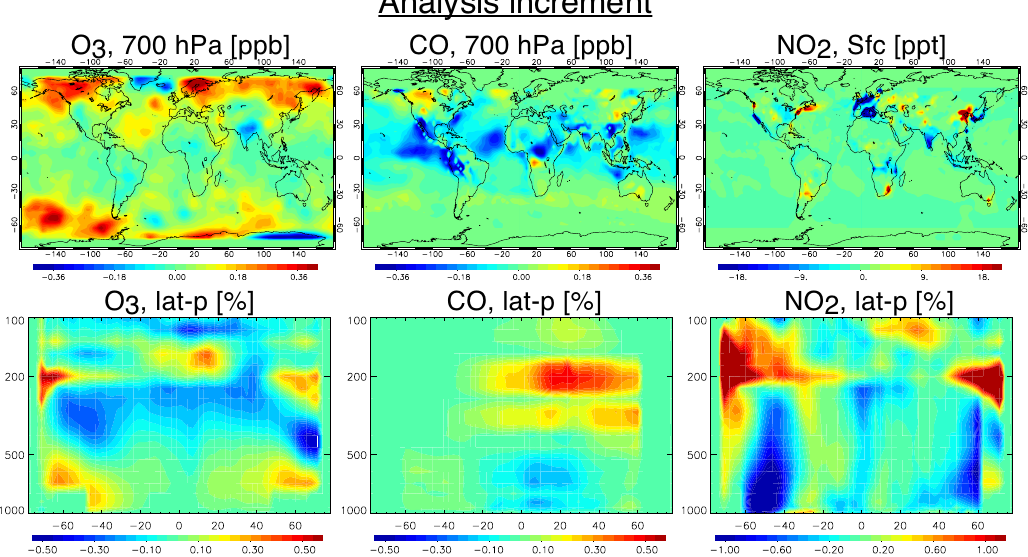
Fig. 17. Same as Fig. 16, but for the analysis increment. Lower panels show the latitude-pressure distribution of the percentage ratio of the zonal mean analysis increment to the zonal mean analysis ensemble mean concentration. The red (blue) colour indicates relatively positive (negative)